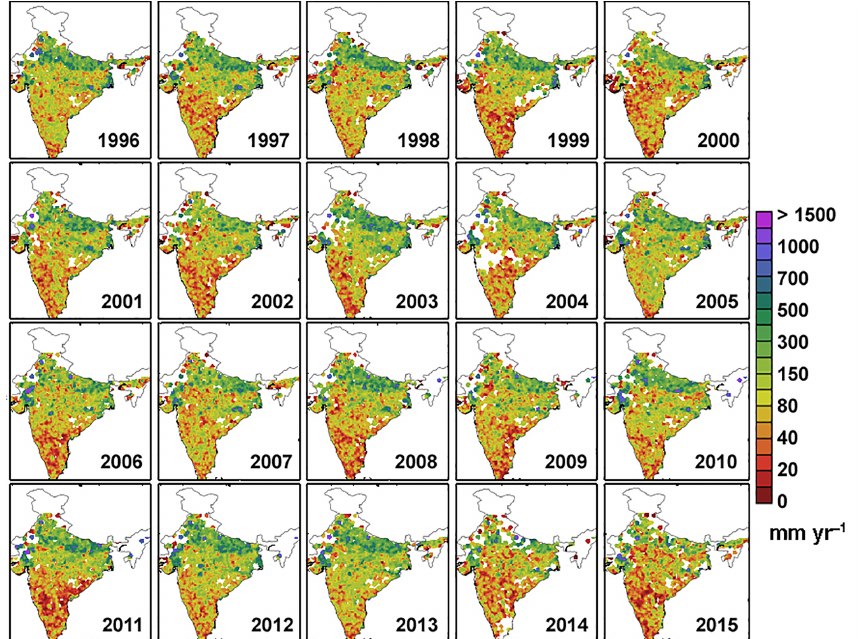
Figure 5. Maps showing gridded (0 . 1 ◦ × 0 . 1 ◦ ) groundwater recharge (mmyr − 1 ) calculated using WTF method. Blank areas represent areas of no data